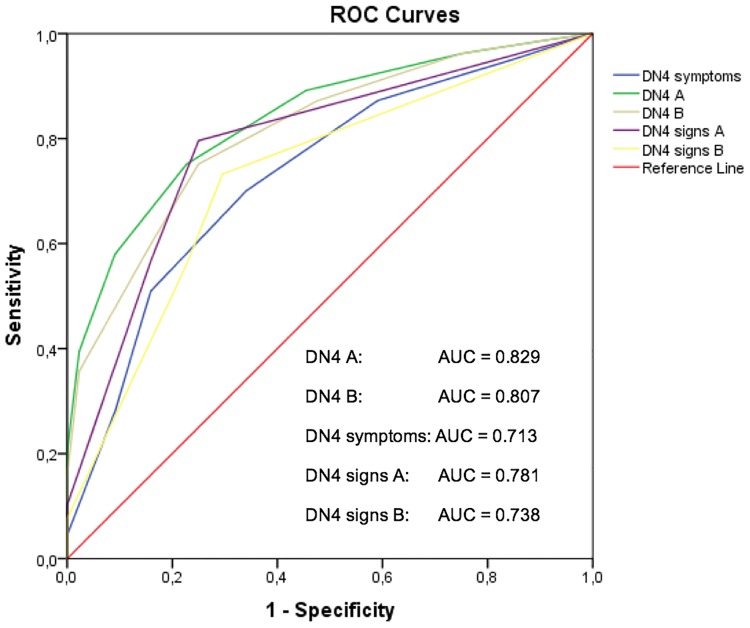
The ROC curve of the DN4, DN4 symptoms and the DN4 signs to the probability of the presence of NePC as classified based on the assessment by the physicians (A and B).DN4: Doleur Neuropathique en 4 questions; DN4-symptoms: the items filled in by the patient; DN4 A: DN4-symptoms filled in by the patient and DN4-signs as asssessed by physicians A; DN4 B: DN4-symptoms filled in by the patient and DN4-signs as asssessed by physicians B; DN4 signs A: DN4-signs as asssessed by physicians A; DN4 signs B: DN4-signs as asssessed by physicians B.